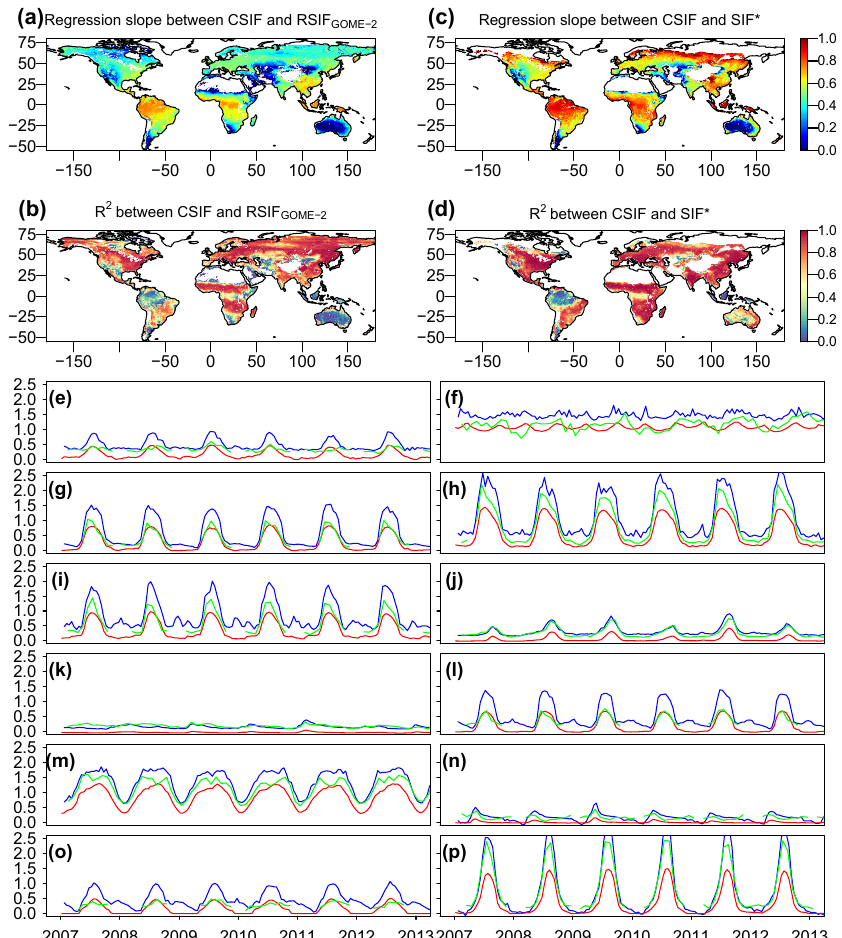
Figure 9. Comparison between CSIF, RSIF GOME-2 and SIF ∗ dataset. Regression slopes and coefficient of determination ( R 2 ) between the contiguous clear-sky condition instantaneous SIF from OCO-2 (CSIF inst-clear ) and the reconstructed SIF from GOME-2 (RSIF GOME-2 a , b ) or SIF ∗ ( c , d ) dataset. The regressions are forced to pass the origin. The CSIF clear-inst is aggregated to semi-monthly and 0 . 5 ◦ × 0 . 5 ◦ spatial resolution to be consistent with RSIF GOME-2 . Comparison uses the data between 2007 and 2016 (RSIF) or 2007 to 2013 (SIF ∗ ). White regions are barren regions. (e–p) Time series comparison among CSIF (red), RSIF GOME-2 (blue) and SIF ∗ (green) for pixels in 12 major land cover types shown in Fig.